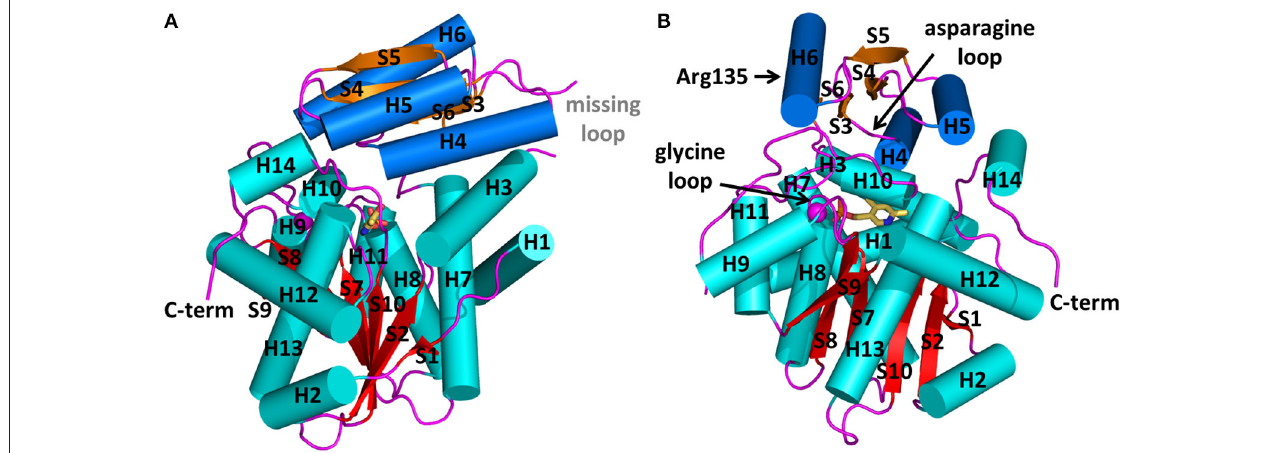
FIGURE 1 | Structure of human serine racemase (PDB code 3L6B) shown in two orthogonal views (A,B) . α -helices and β -strands belonging to the large domain are colored in cyan and red, respectively, while those belonging to the small domain are reported in blue and orange, respectively. The divalent cation is represented as a pink sphere. All loops are colored in pink. The positions of the asparagine and glycine loops and of Arg135 are indicated by arrows.